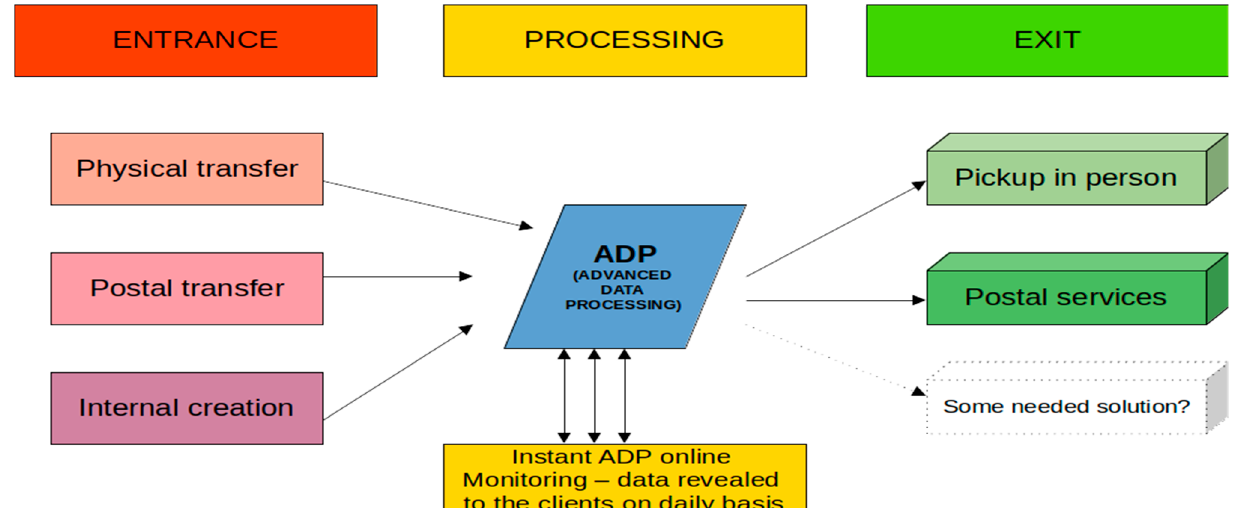
Figure 2. The document flow throughout the company.